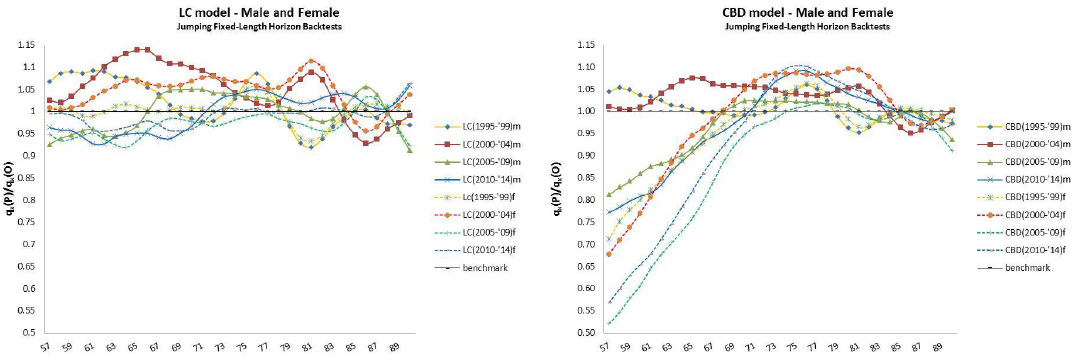
P x , t Figure 12. LC and CBD q ratio: comparison between models. Note: the curves represent the average q O x , t q P x , t of the ratio over the five-years forecast q O x , t